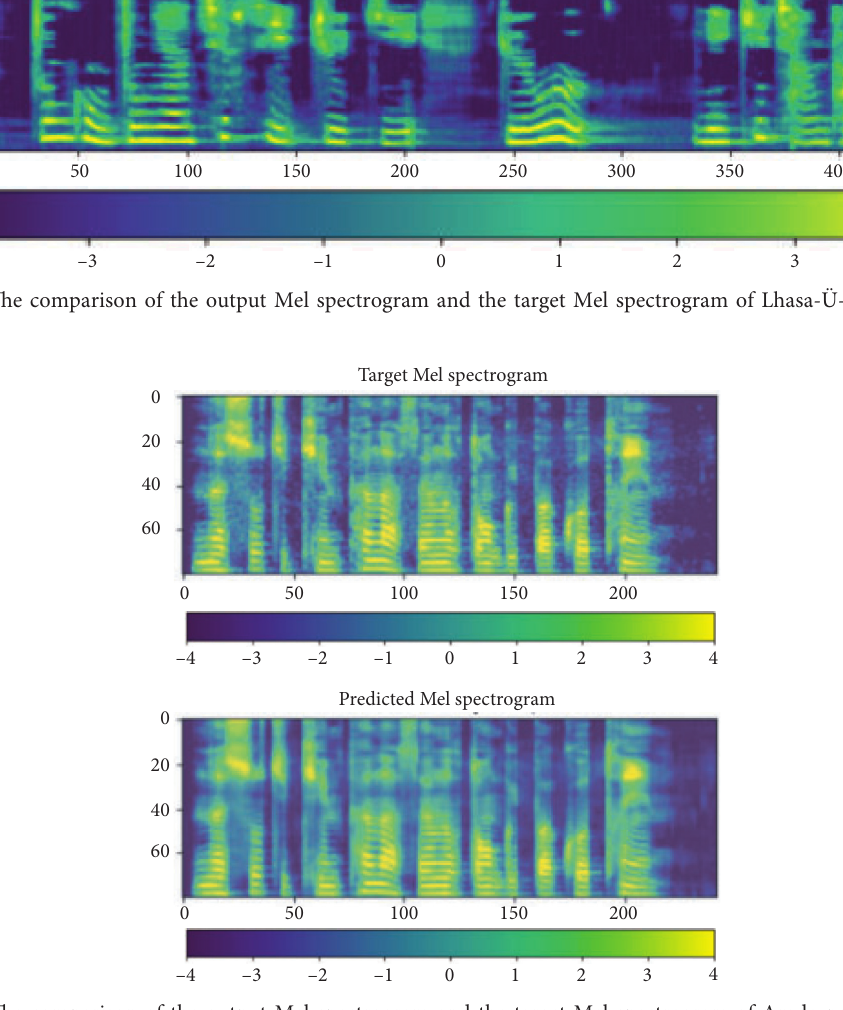
Figure 7: The comparison of the output Mel spectrogram and the target Mel spectrogram of Amdo pastoral